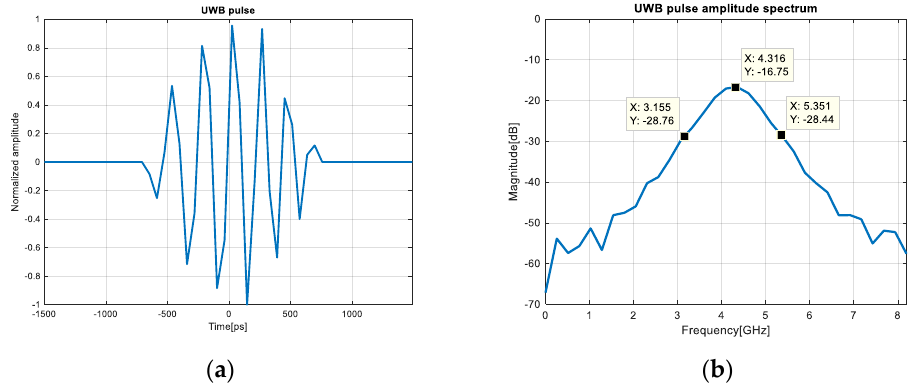
Figure 3. ( a ) Emitted signal, ( b ) amplitude spectrum of the emitted signal.